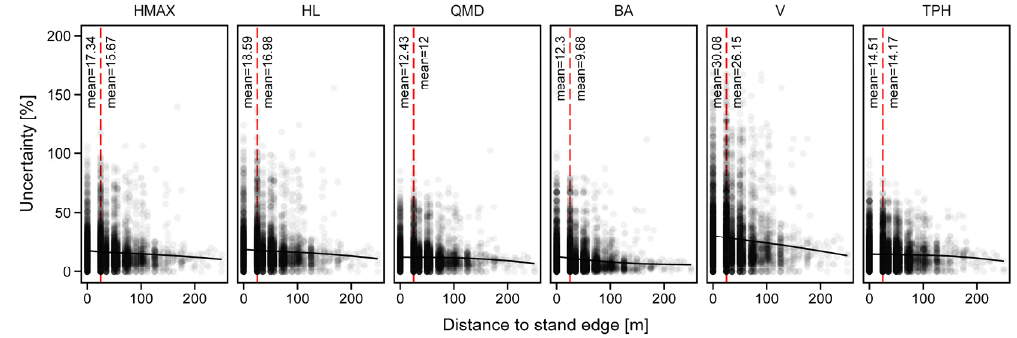
Figure 6. Relationship between distance to stand edge and uncertainty among predicted variables. Dashed red line indicates the division between border and core cells (distance = 25 m). Black solid line indicates loess trend line.